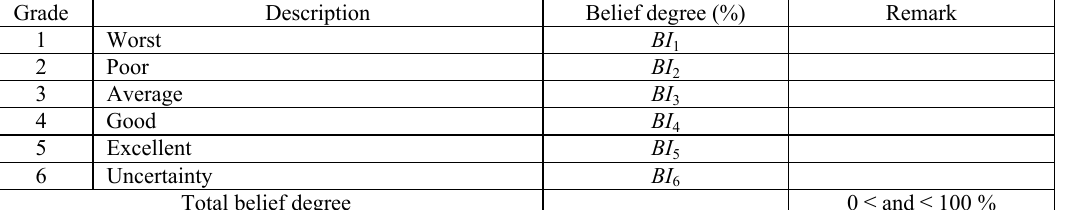
Table 2 Aggregation of assessments on a survey statement’s